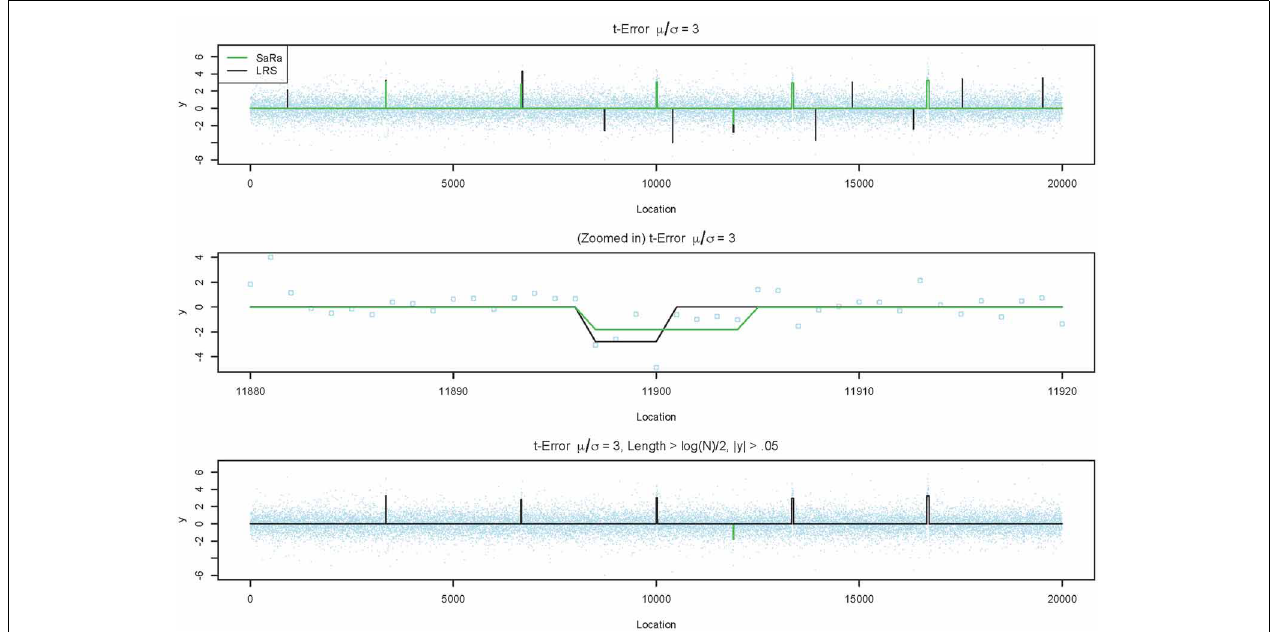
FIGURE 3 | LRS and SaRa results on simulation before and after pruning. The top figure runs the standard LRS and SaRa procedure and results in a few false positives. The middle figure shows the difference width and